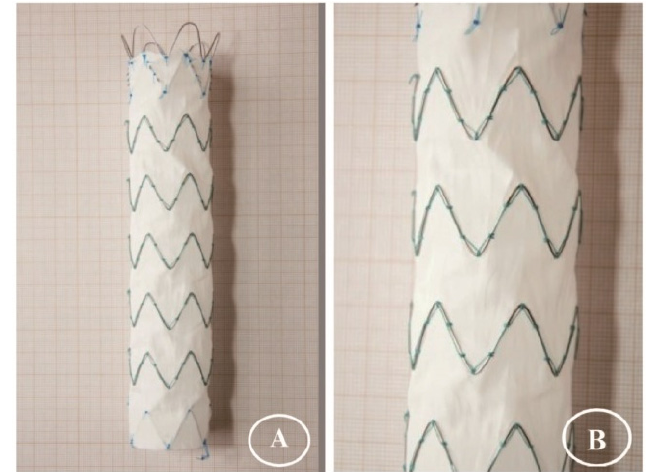
Figure 14. Thin wall Cook LP. Compared to the bifurcated stent ‐ graft, the straight tubular device is less vulnerable to damage from twisting ( A ). Though the moderate angles of the Z ‐ stents are less likely to damage the fabric, twisting may not be completely eliminated in cases with poor device deployment or complex anatomy. This could cause concentration of twisting in the unsupported fabric between two adjacent Z ‐ stents ( B ).